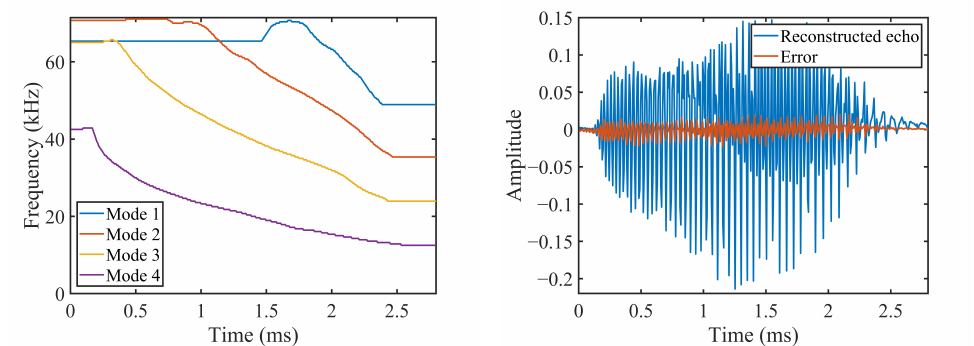
Figure 12. The estimated IF and mode reconstruction of bat echo. ( a ) The estimated IF trajectories based on the MSRT. ( b ) Mode reconstruction results and